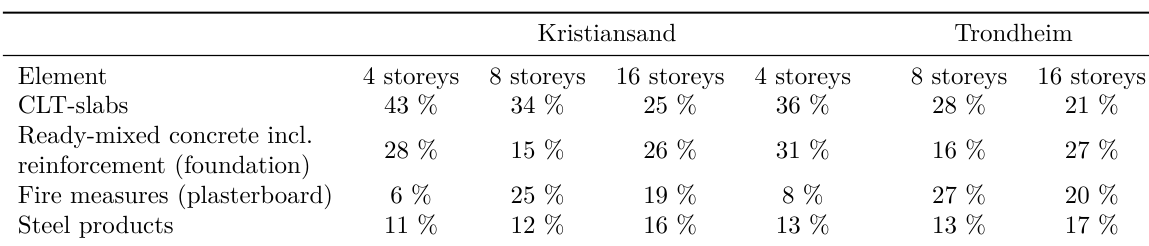
Table 3. Share of fossil GHG emissions in percentage from di ff erent construction materials in wood-based load- bearing structures of 4-, 8- and 16-storey located in Kristiansand and Trondheim.